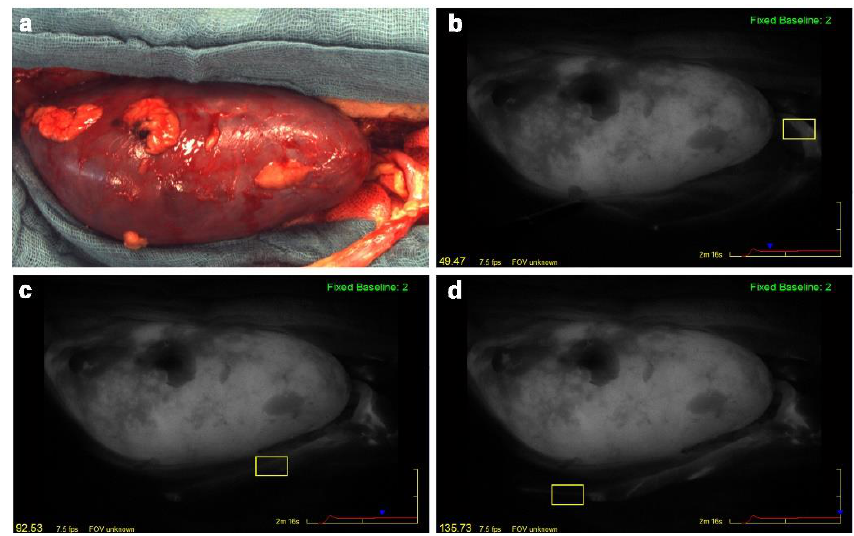
Figure 1. Intraoperative photo ( a ) and quantitative assessment of the graft ureter microperfusion ( b – d ) during kidney transplantation with ICG fluorescence analysis (SPY Elite). The ureter is positioned in the right bottom. Microperfusion was evaluated separately for each third of the ureter with the SPY-Q software by selecting regions of interest (yellow boxes): ( b ) proximal; ( c ) middle; ( d ) distal ureteral third.